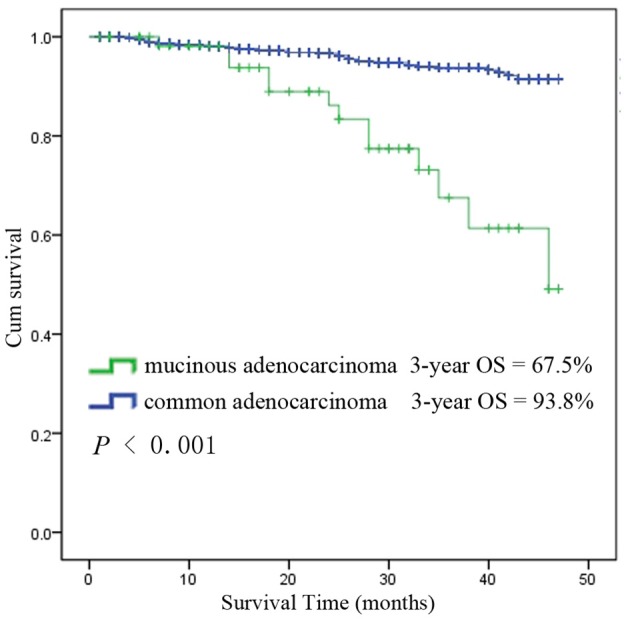
Kaplan-Meier survival curves for mucinous adenocarcinoma and common adenocarcinoma among all patients with pCR.